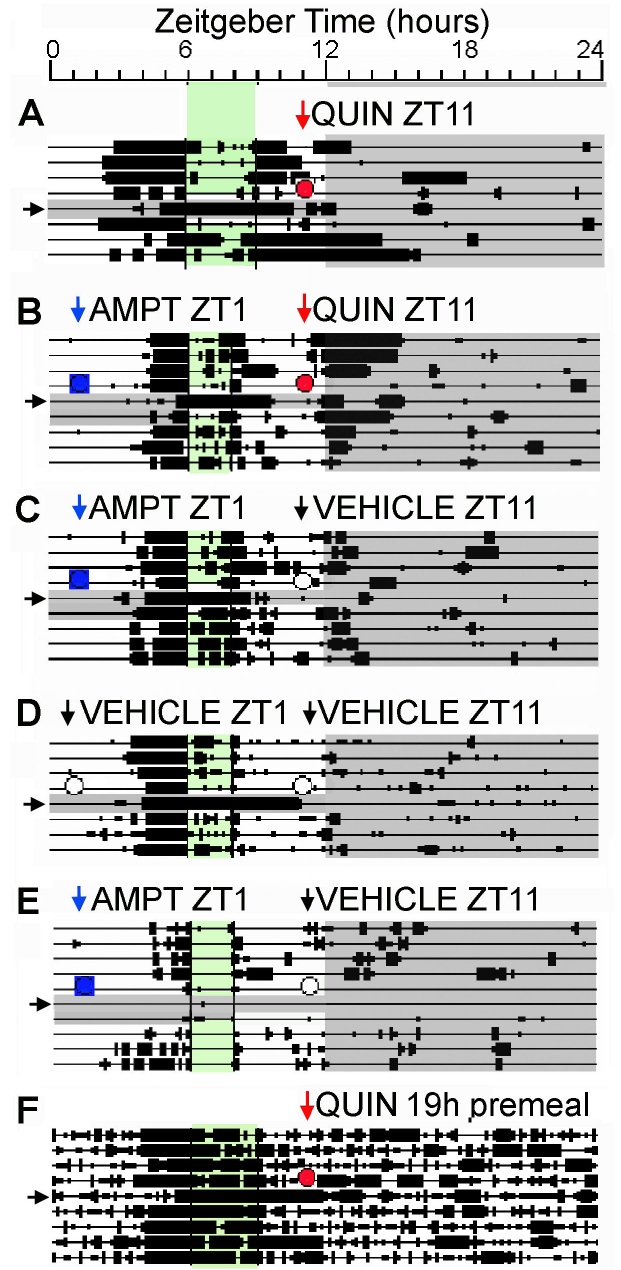
Figure 1. Activity of rats during restricted feeding, and effects of drug and vehicle injections. Each line represents 24h of recording, with time in 10 min bins plotted from left to right, and consecutive days aligned vertically. Time bins during which 1 or more wheel revolutions (A-E) or general activity counts (F) were registered are represented by heavy bars, the height of which corresponds to activity level (in quartiles). Mealtime occurred between hours 6-9 (Panels A, F) or 6-8 (Panels B-E) and is shaded green. Injections are denoted by red circles and arrows for quinpirole (QUIN, 1 mg/kg), blue squares and arrows for alpha- methylparatyrosine (AMPT, 200 mg/kg), and unfilled circles and black arrows for vehicle (sterile water). Grey shading indicates lights-off, as part of the daily LD cycle or the 1 or 2 days following drug injections. Food anticipatory activity onset was measured on the 4 days prior to injections and on the day after injections. Food anticipatory activity onset was delayed on the day following quinpirole (A,F) or quinpirole with AMPT pretreatment (B), but was not delayed on the day following AMPT (C) or vehicle alone (D). Some rats stopped using the running wheels for 2 or more days after AMPT and could not be used to measure phase shifts (e.g., E). doi: 10.1371/journal.pone.0082381.g001 PLOS ONE |